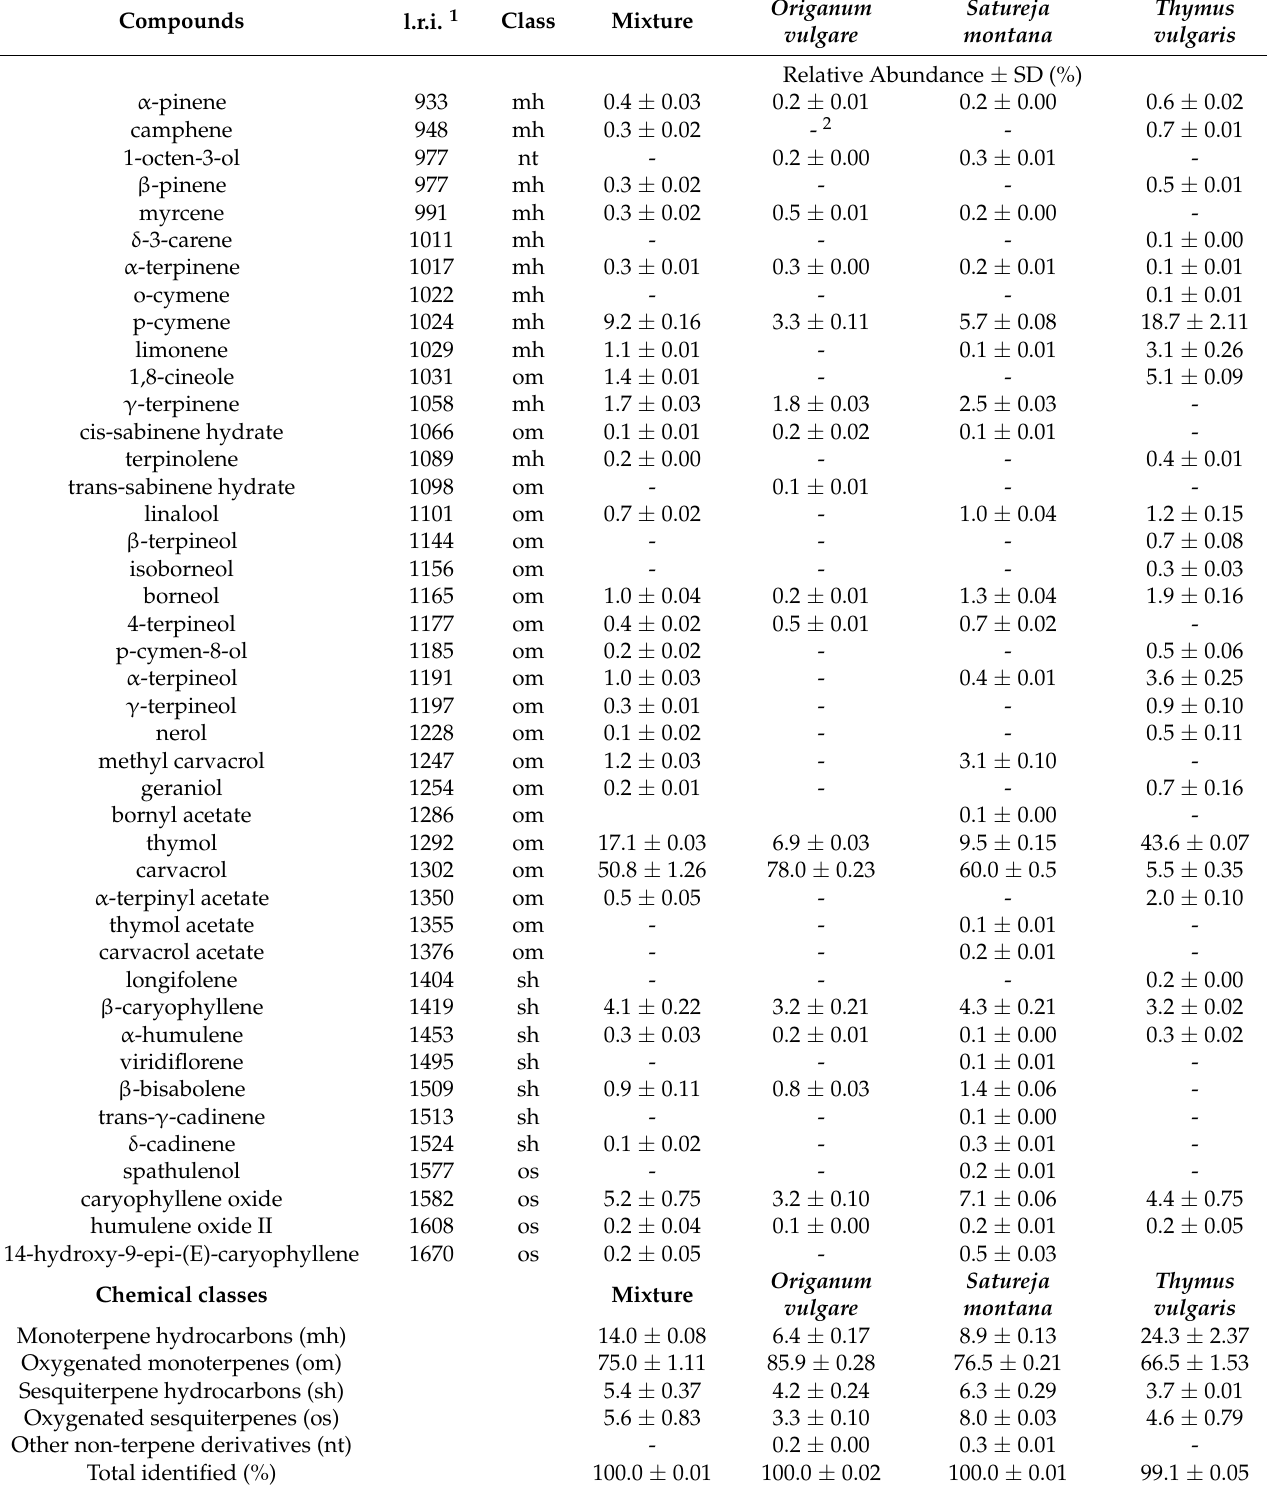
Table 1. Relative percentage of the main constituents of the tested essential